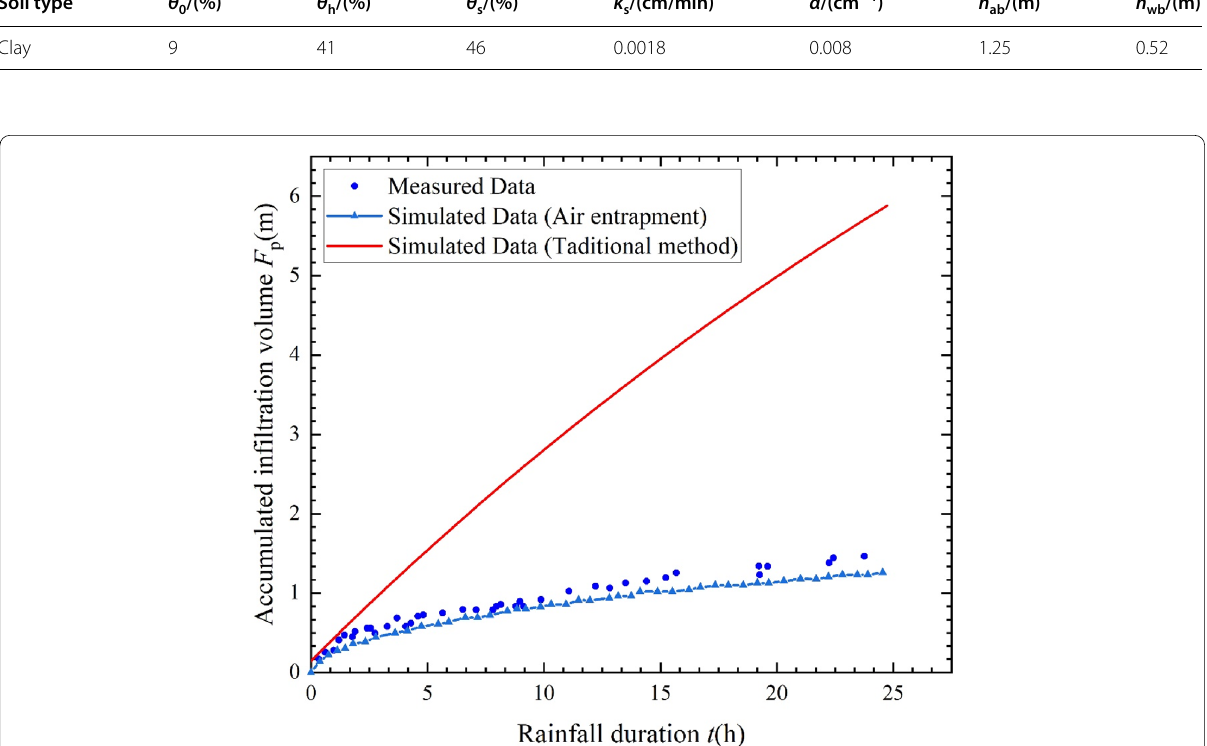
Fig. 3 Relationship between the accumulated infiltration volume and rainfall